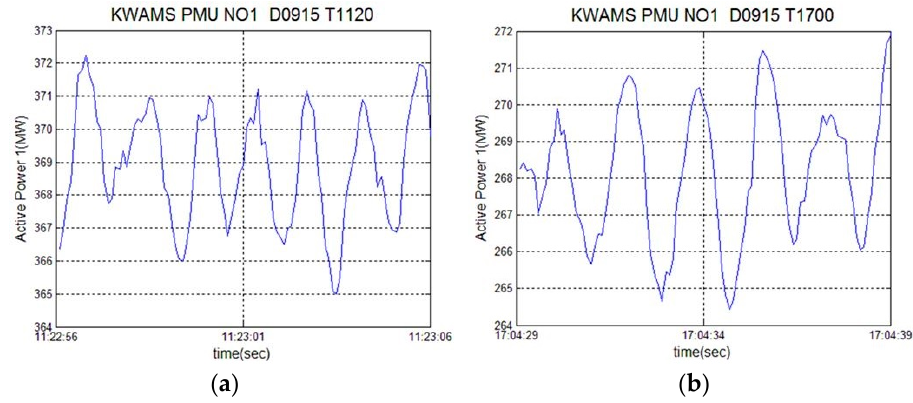
Figure 3. Active power for 10 s with dominant oscillation. ( a ) at time 11:22; and ( b ) at time 17:04.